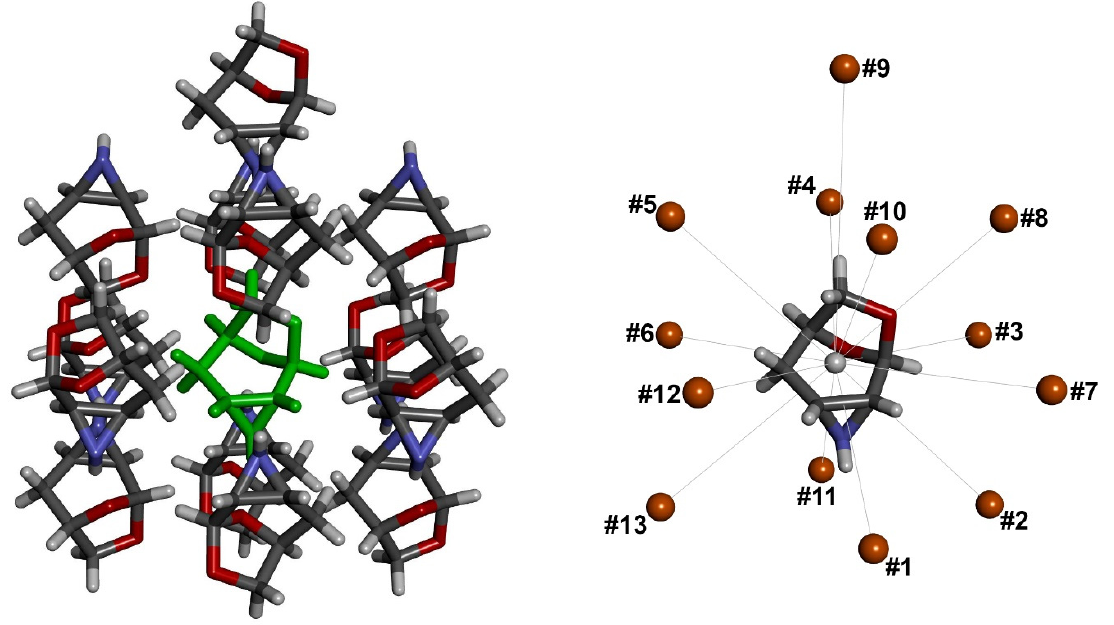
Figure 3. Molecular packing in I (left) and coding of the surrounding molecules expressed as molecular centroids (right).